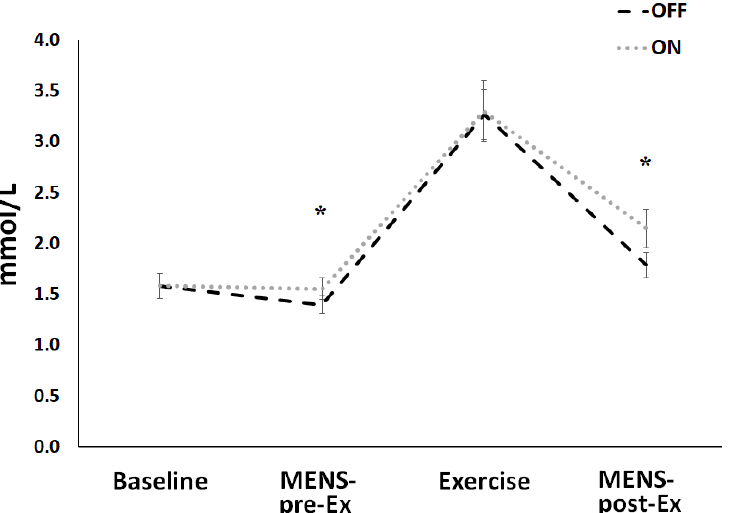
Figure 4. Mean (±SD) lactate values recorded at the baseline, after the first MENS treatment (MENS-pre-Ex) before exercise, at the third minute of the constant-load exercise (Exercise), and after the second MENS treatment (MENS-post-Ex), subsequently to exercise performance. Black dashed line represents OFF, the gray dashed line represents ON condition. Asterisks showed mean significant differences at p < 0.05.